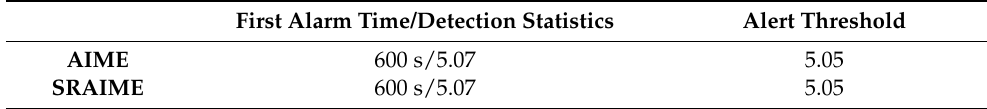
Figure 14. The slowly-growing gross error detection results of Wilford Bridge by GNSS/accelerom- eter fusion after adding gross errors: ( a ) Detection statistics after adding gross errors; ( b ) Alert situ- ation after adding gross errors. Table 3. Wilford Bridge Statistics of AIME/SRAIME gross error detection results.